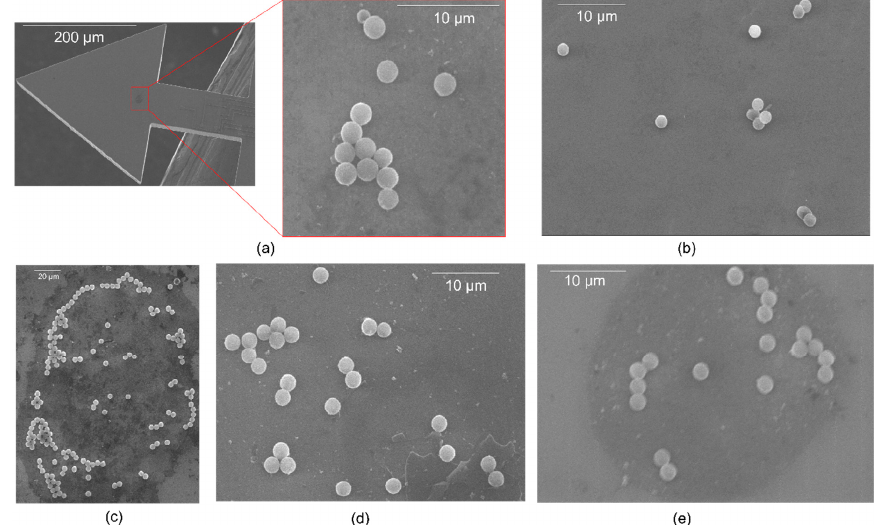
Figure 13. Typical SEM images of the adsorbates of magnetic polystyrene (MPS) microparticles on our various silicon-based piezoresistive TCant1 and TCant2 triangular cantilever sensors with ( a – e ) respectively denoting B46T1, F22T2, B24T1, A16T1, and A14T1 cantilevers. The SEM-counted number of particles in ( a – e ) are ∼ 13, 11, 160, 25, and 18, respectively. From all the cantilever samples, a monolayer particle assembly was clearly observed. These MPS µ Ps were deposited on the cantilevers utilizing the particle-imprint method.